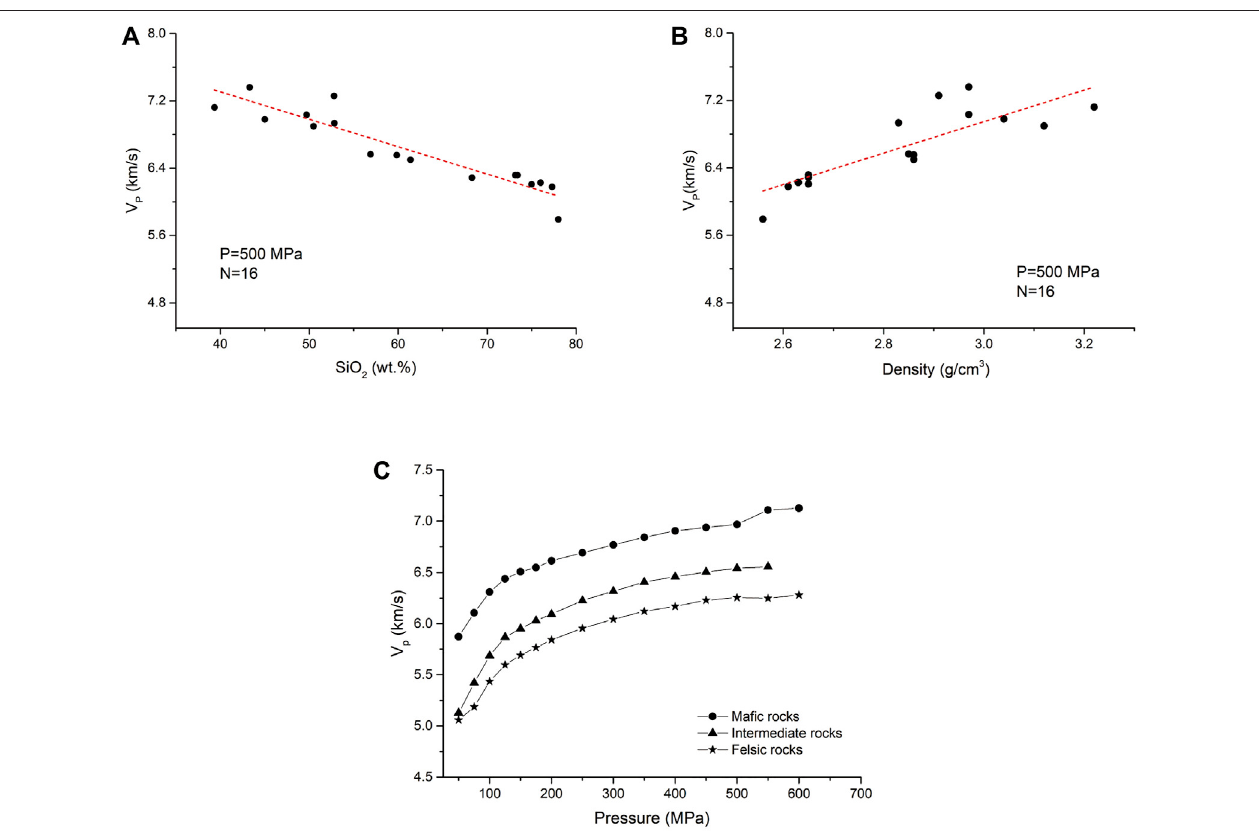
FIGURE4|(A) RelationshipbetweenthewavevelocityandtheSiO 2 contentunderapressureof500 MPa(foranisotropicsamples,thevaluesareaveragedintwo directions). (B) Relationship between the wave velocity and the density under a pressure of 500 MPa. (C) Wave velocities of felsic, intermediate, and ma fi c rocks as a function of the